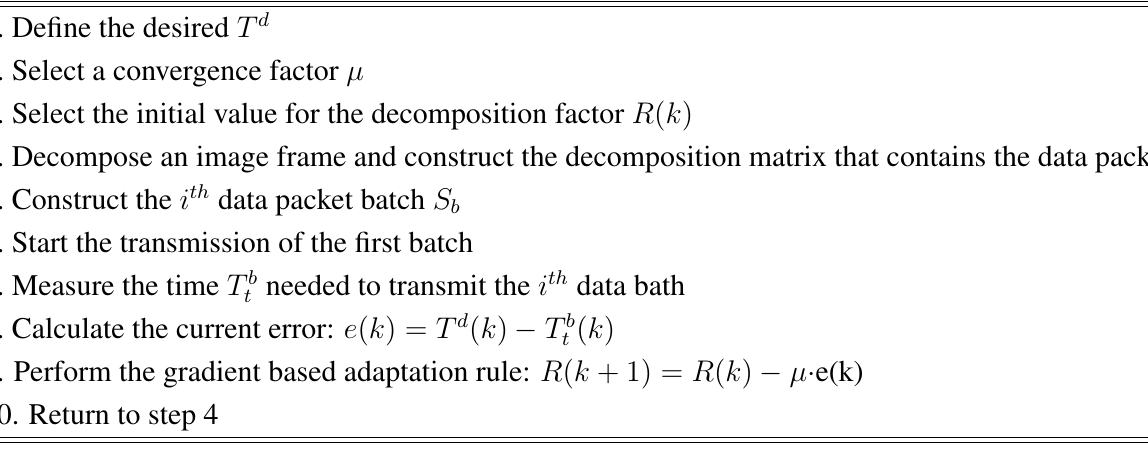
Table 1 . Gradient Based Adaptive QoS Scheme